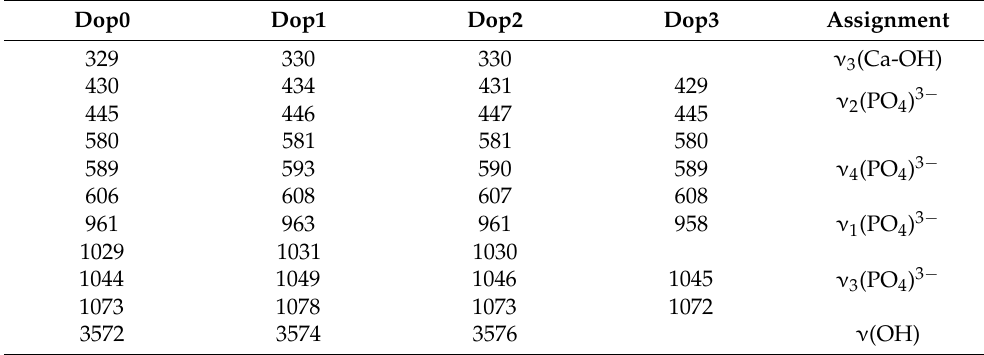
Figure 10. Raman spectra of Sr-doped HAp samples compared with the undoped HAp in 300–1200 cm − 1 ( a ) and 3500–3700 cm − 1 ranges ( b ). Table 6. Raman band positions (wavenumbers, cm − 1 ) and relative assignments for Sr-doped and undoped HAp